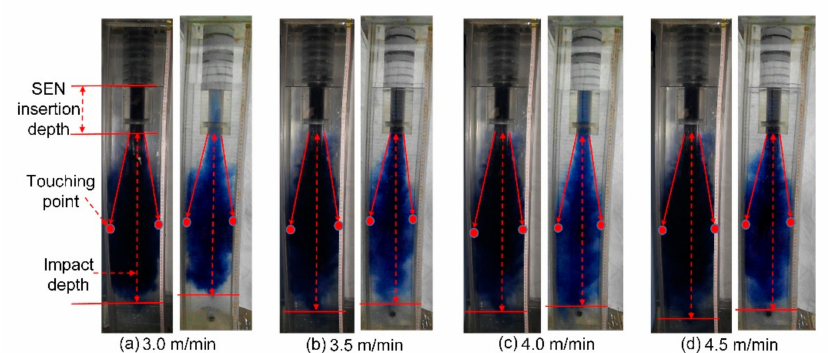
Figure 5. Comparison of the flow field in the mold at various casting speeds obtained via the hydraulic modeling experiment without a solidified shell (left), and with a solidified shell and hydrostatic pressure (right). ( a ) 3.0 m / min; ( b ) 3.5 m / min; ( c ) 4.0 m / min; ( d ) 4.5 m / min.